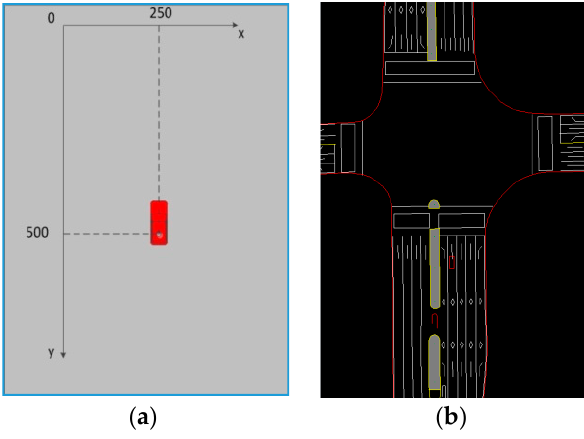
Figure 11. System introduction. ( a ) Local coordinate system; ( b ) road map.